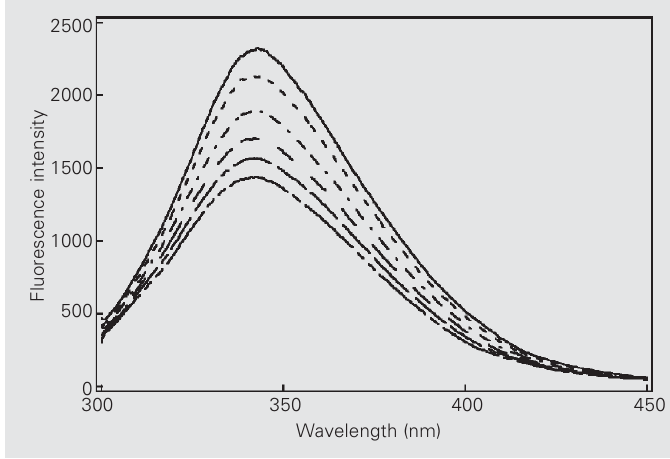
Figure 3. Effect of zinc phthalocyanine concentration on the fluorescence spec- trum of bovine serum albumin. From the top, in order of decreasing fluores- cence intensity with excitation at 290 nm, ZnPC concentration was 0.00, 0.13, 0.38, 0.64, 0.89, and 1.14 µM.